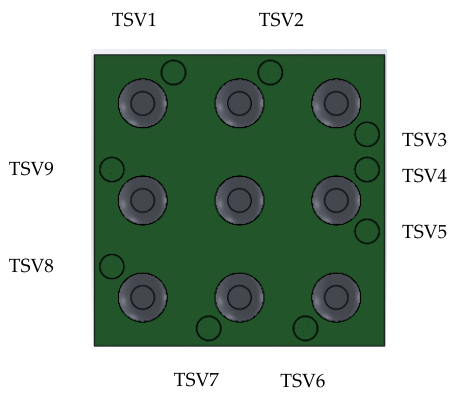
Figure 4. MEMS package with solder joints (view from board side).